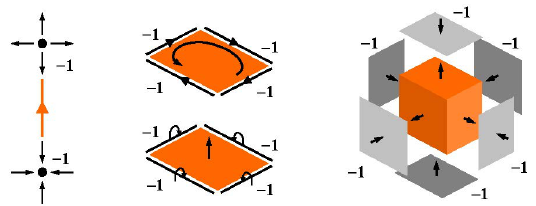
Figure 52: Examples of incidence numbers equal to − 1.